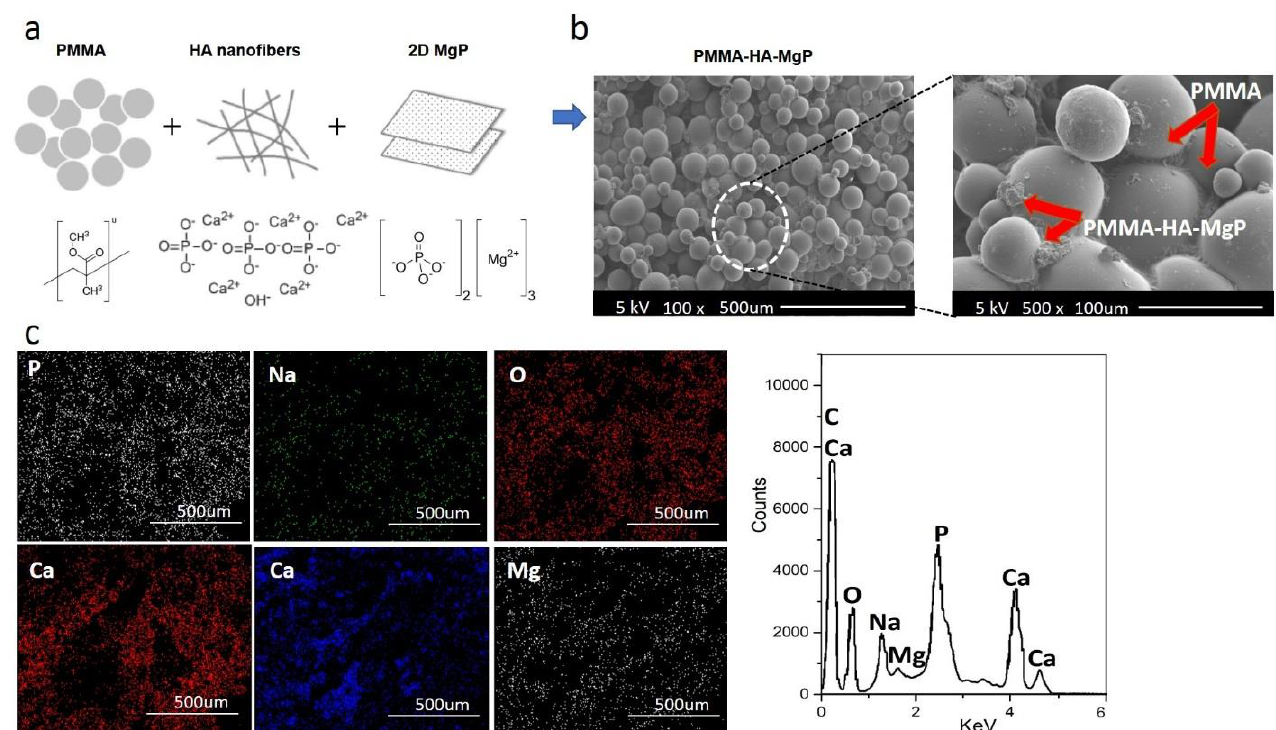
Figure 3. Characterization of the PMMA-MgP-HA nanocomposites: ( a ) schematic diagram for the formation of nanocom- posite, ( b ) the SEM images in two different magnifications, and ( c ) the EDS mapping mode and the EDS spectrum.